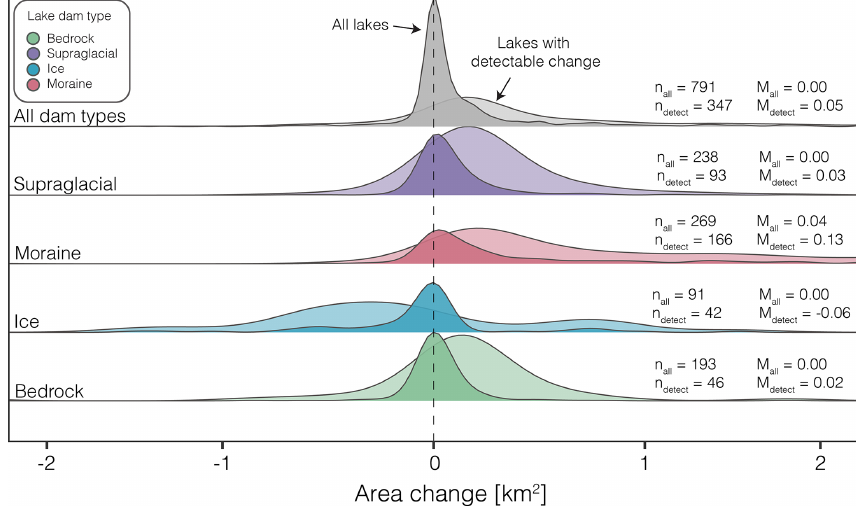
Figure 7. Smoothed density distribution (normalized to 1 for each dam type) of absolute lake area change for all lakes (dark curves) compared to that for only lakes with detectable change (light curves) for each dam type, with number of lakes ( n ) and median lake area change ( M ). Note that the x axis has been limited to − 2 and 2km 2 . For the full distribution, see Fig.